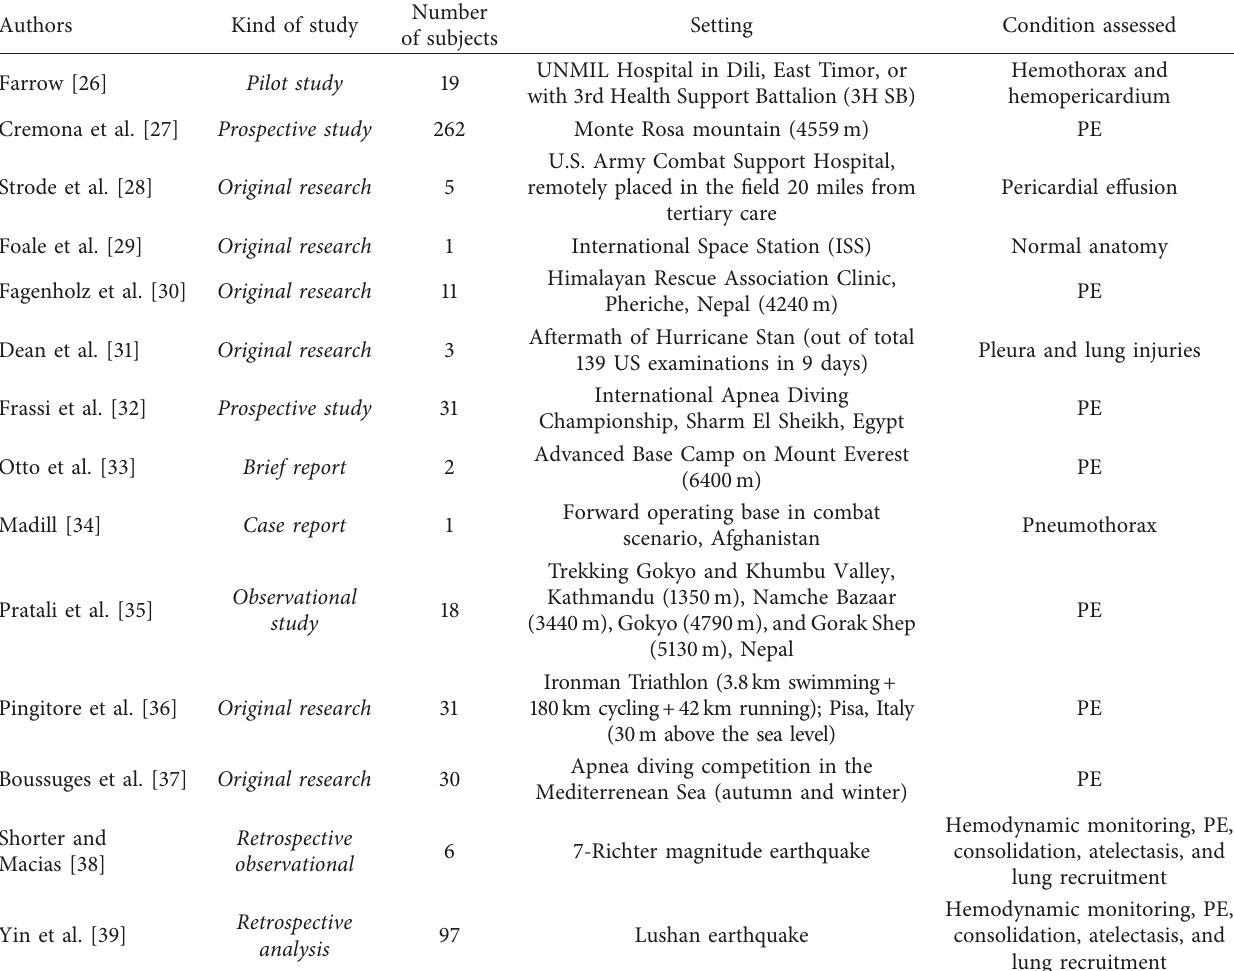
Table 1: Applications of CU in extreme settings according to the